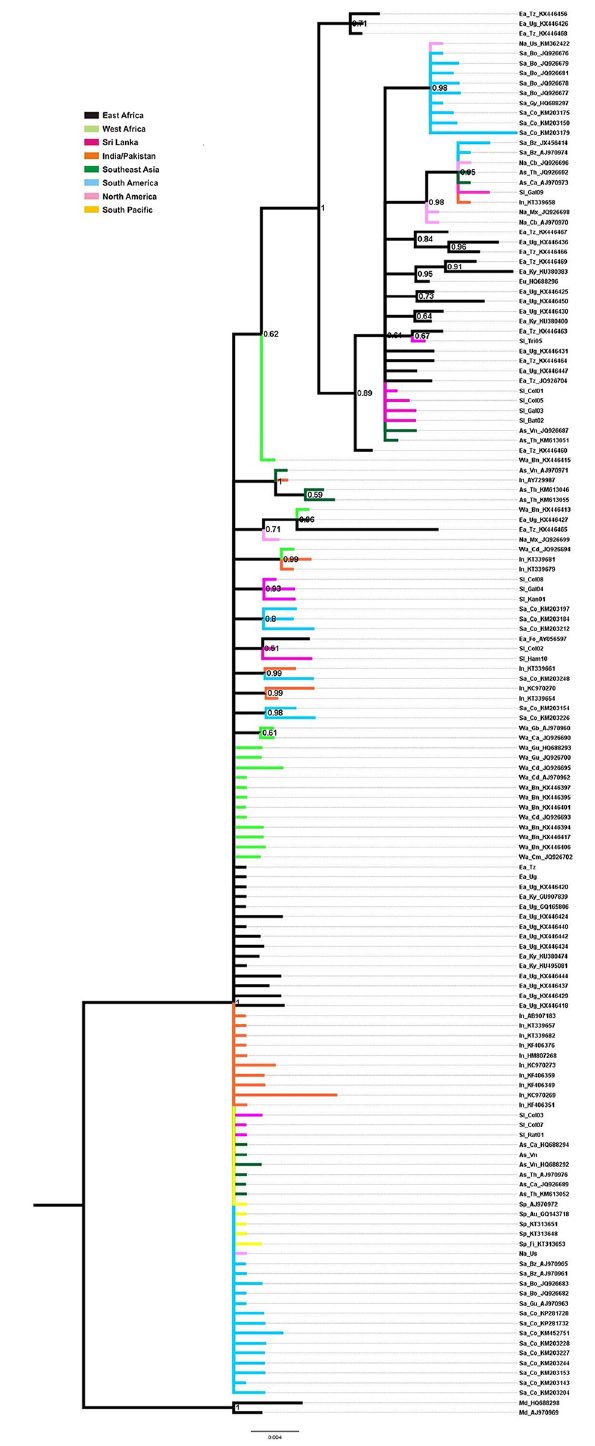
Fig 3. Bayesian phylogenetic tree of relationships of Ae . aegypti based on CO1 gene. The support values written on the branches correspond to posterior probabilities. The branch lines are colored by geographic distribution of the corresponding